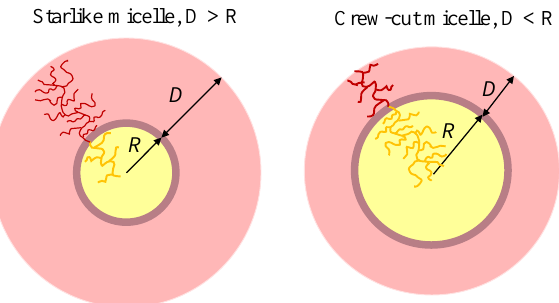
Figure 2. Schematics of starlike, D (cid:29) R , and crew-cut, D (cid:28) R , micelles formed by copolymers with bottlebrush